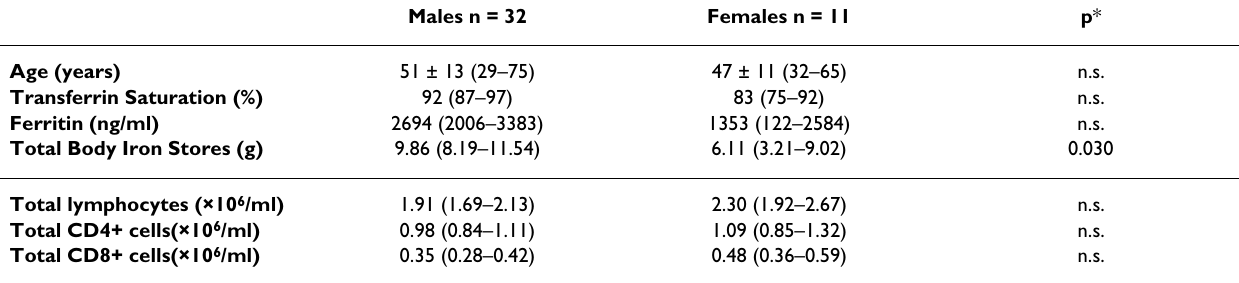
Table 1: General characterization of C282Y homozygous probands at the time of diagnosis according to